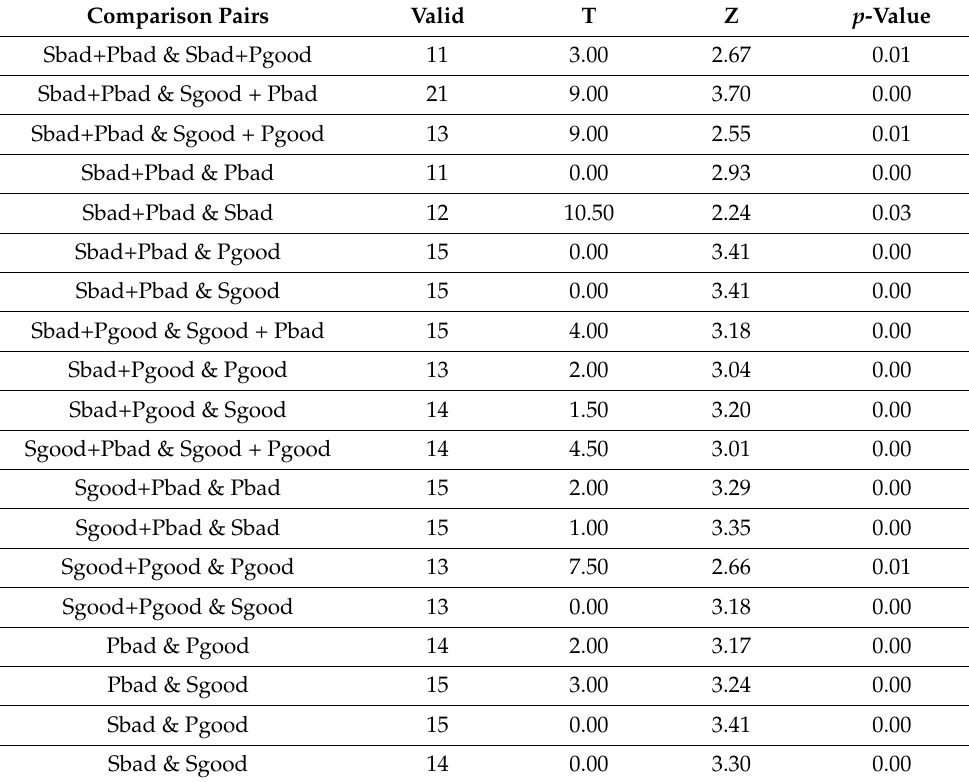
Table 1. Significant variations in stimuli of different modalities (visual–photos; audial–sounds) and different valence (positive, negative); comparison with the paired Wilcoxon W-test.